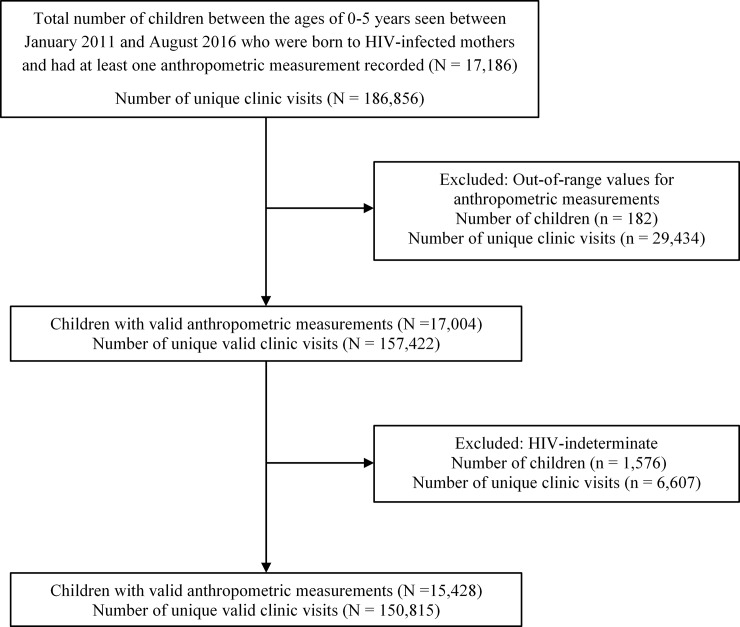
Flow diagram of study population selection.